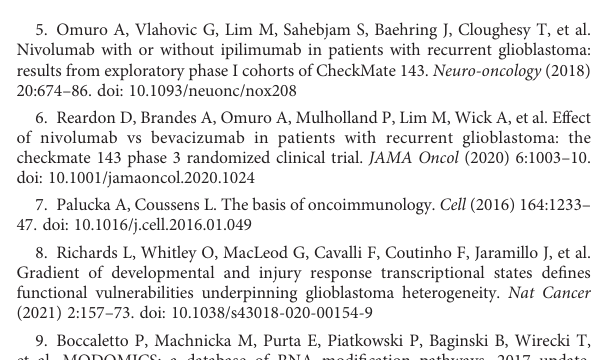
SUPPLEMENTARY FIGURE 4 Kaplan-Meier curves displaying prognostic differences between different clusters in the CGGA #325 cohort. SUPPLEMENTARY FIGURE 5 Analysis of stemness, genomic heterogeneity and Immune microenvironment features in LGG subgroup. (A) Kaplan-Meier curves displaying prognostic differences between cluster 3 and cluster 4 in the LGG subgroup. (B – G) Differences in stemness score between cluster 3 and cluster 4 in the LGG subgroup. (H – L) Differences in genomic heterogeneity between cluster 3 and cluster 4 in the LGG subgroup. (M – O) Differences in immune microenvironment between cluster 3 and cluster 4 in the LGG subgroup. (P) Differences in in fi ltration of 22 immune cells between cluster 3 and cluster 4 in the LGG subgroup. *, P < 0.05; **, P < 0.01; ***, P 0.001; ****, P < 0.0001. SUPPLEMENTARY FIGURE 6 Validation of the risk signature in the CGGA #325 and CGGA #693 cohorts. (A) Distribution of the risk score, survival status, and expression pro fi le of the prognostic genes in the CGGA #325 cohort. (B) Kaplan- Meier curves displaying prognostic differences between high- and low- risk groups in the CGGA #325 cohort. (C) The ROC curves describing the sensitivity and speci fi city of risk score in predicting OS at 1-, 3- and 5-year time points in the CGGA #325 cohort. (D) Distribution of the risk score, survival status, and expression pro fi le of the prognostic genes in the CGGA #693 cohort. (E) Kaplan-Meier curves displaying prognostic differences between high- and low-risk groups in the CGGA #693 cohort. (F) The ROC curves describing the sensitivity and speci fi city of risk score in predicting OS at 1-, 3- and 5-year time points in the CGGA #693 cohort. SUPPLEMENTARY FIGURE 7 Validation of the risk score in LGG subgroup. (A) Kaplan-Meier curves displaying prognostic differences between high- and low-risk groups in the LGG subgroup. (B) The ROC curves describing the sensitivity and speci fi city of risk score in predicting OS at 1-, 3- and 5-year time points in the LGG subgroup. SUPPLEMENTARY FIGURE 8 Validation of the risk score in the IMvigor210 cohort. (A) Boxplot depicting the risk scores between SD/PD and CR/PR groups in the IMvigor210 cohort. (B) Differences inthenumberrespondersbetweenhigh- andlow- risk groups in the IMvigor210 cohort. (C) Kaplan-Meier curves displaying prognostic differences between high- and low-risk groups in the IMvigor210 cohort. *, P < 0.05; **, P < 0.01; ***, P < 0.001; ****, P < 0.0001. SUPPLEMENTARY TABLE 1 Primers and siRNAs used in this